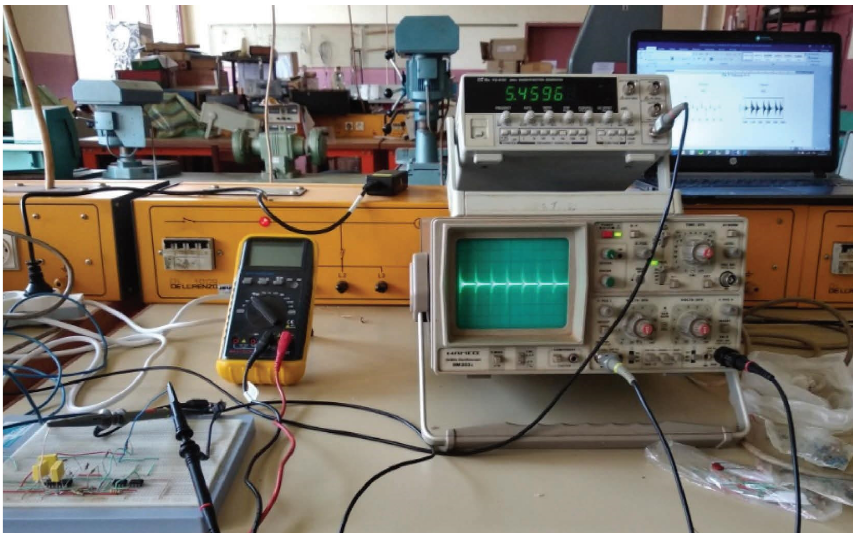
Figure 3: A snapshot of the experimental